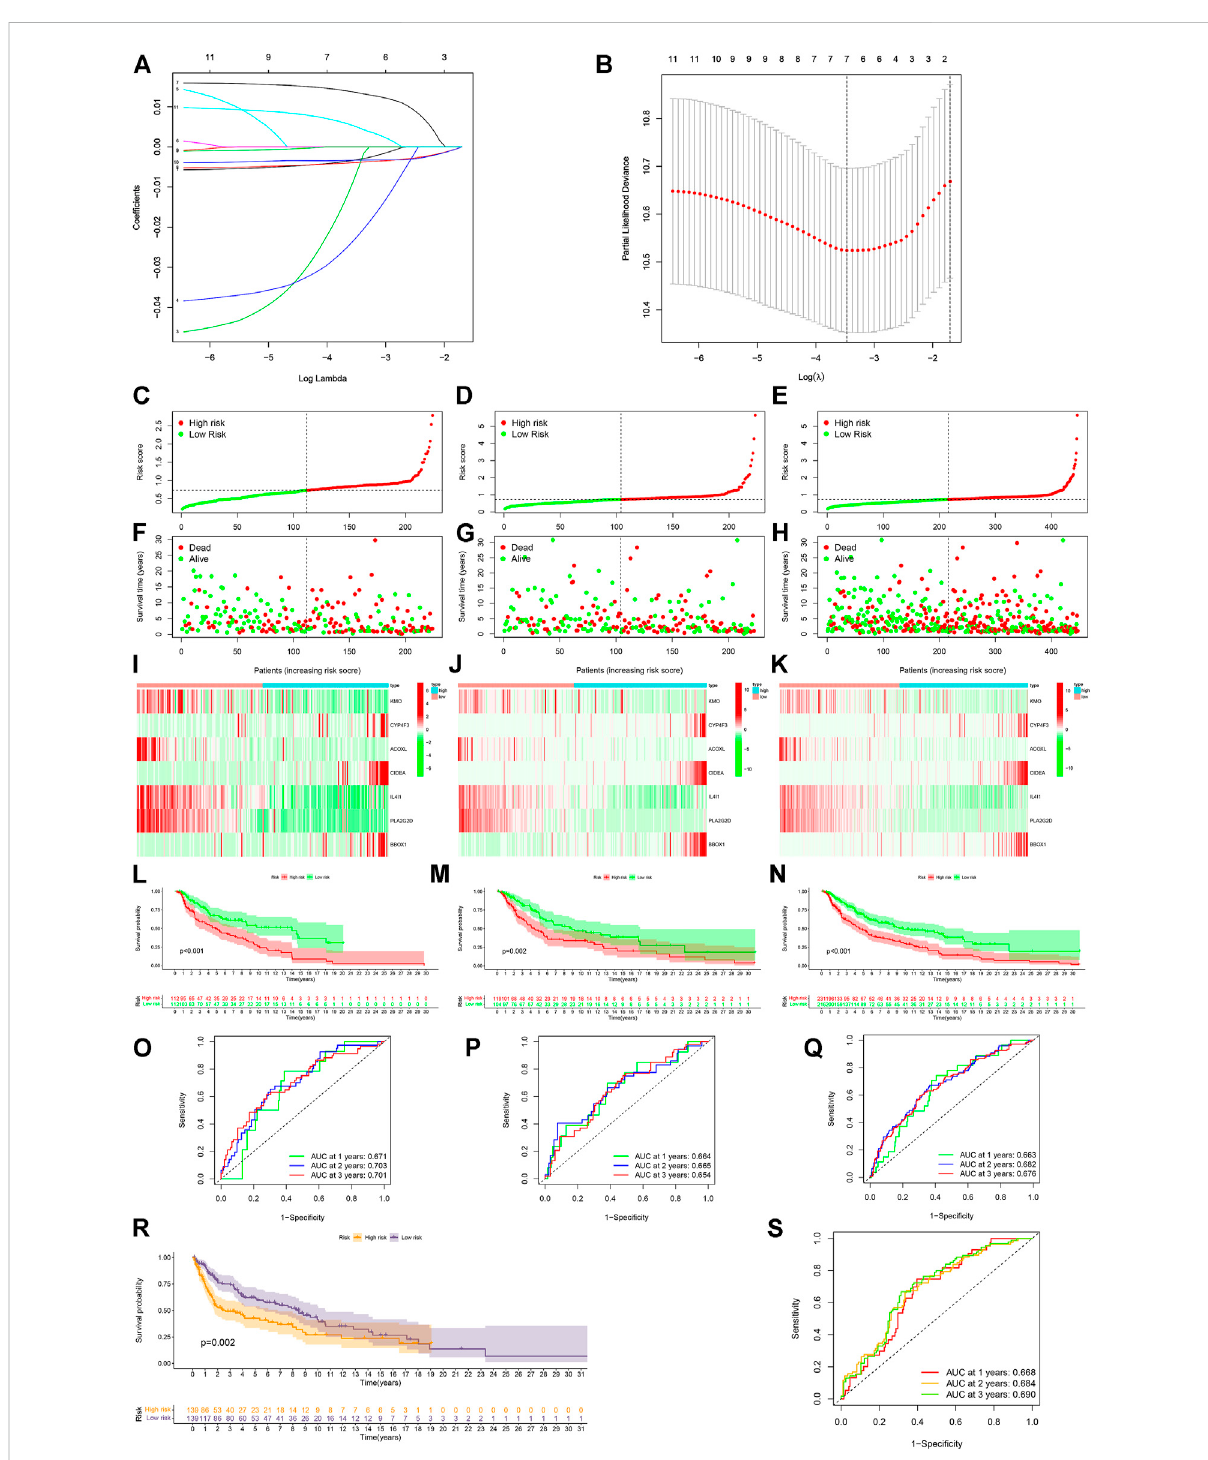
FIGURE 5 Construction and validation of the risk model. (A,B) Constructing a risk model of seven genes by LASSO regression. (C – E) Risk scores of the training, testing, and entire sets, respectively. (F – H) Survival status of individual cases between the low- and high-risk groups in the training, testing, and entire sets. (I – K) Heatmap of seven gene expression in the training, testing, and entire sets of CM cases. (L – N) Kaplan – Meier analysis of OS between the low- and high-risk groups of CM cases in the training, testing, and entire sets. (O – Q) ROC curves for 1-, 2- and 3-year OS of CM cases in the training, testing, and entire sets. (R) External validation of the risk model. (S) ROC curves for 1-, 2- and 3-year OS of CM case in the external validation cohort. A p value of < 0.05 was considered to indicate a statistically signi fi cant